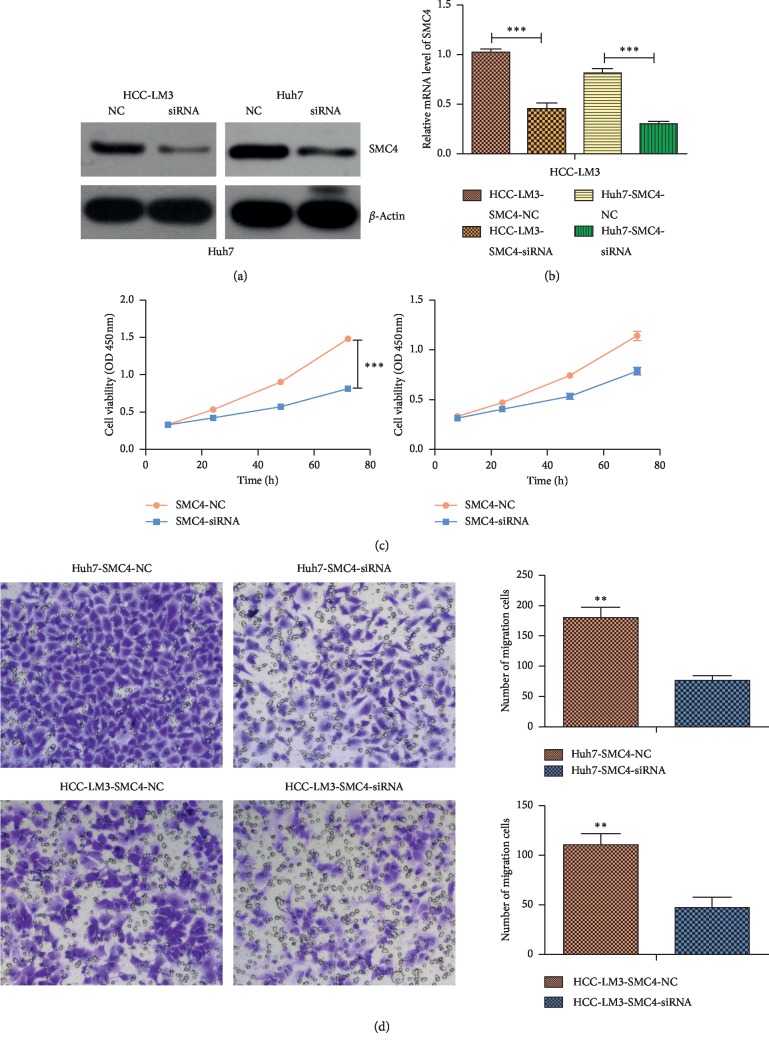
SMC4 could regulate proliferation and migration of HCC cells under hypoxia. (a-b) Efficiency of SMC4 siRNA was verified on both protein and mRNA levels in HCC cells. n = 3, ∗∗∗p < 0.0005. (c) CCK-8 was used to detect cell viability of HCC cells with SMC4 siRNA and negative control under hypoxic condition. The value of 72 h was statistically analyzed. n = 7, ∗∗∗p < 0.0005. (d) Transwell assay was used to detect cell migration ability of HCC cells with SMC4 siRNA and negative control under hypoxic condition., n = 3, ∗∗p < 0.005.